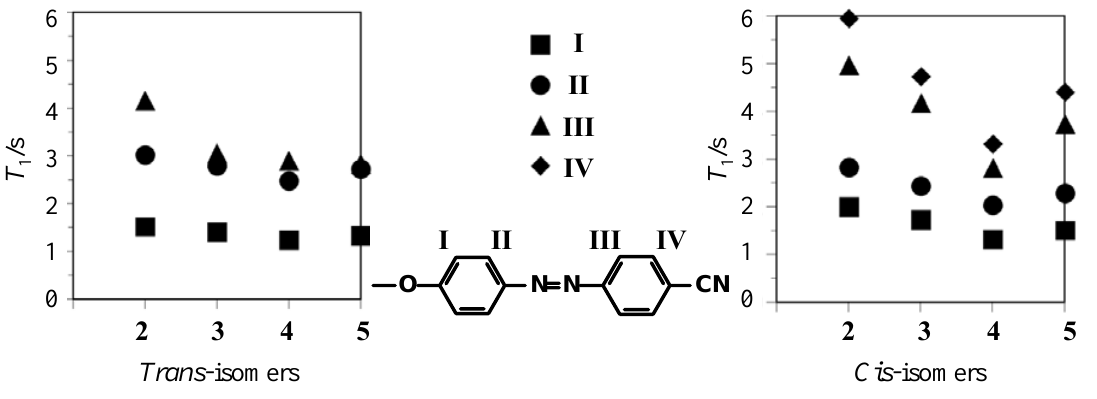
Figure 3. T 1 values of the 1 H on the azobenzene unit of 2 , 3 , 4 and 5 in THF- d 8 .